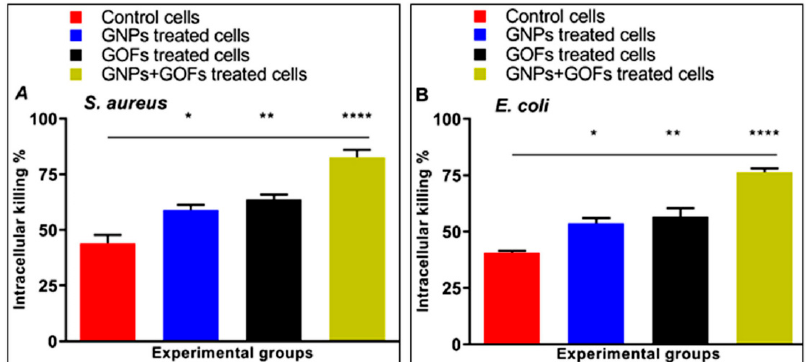
Figure 3. GNPs and GOFs increased the intracellular killing of ingested bacteria by bone-marrow-derived macrophages (BMDMs). Data are represented as mean ± SE. Statistical significance by one-way ANOVA ( p < 0.0001) followed by posthoc testing using Tukey’s multi group comparison with control cells: ( A ) * p = 0.03, ** p = 0.007, **** p < 0.0001 indicate statistically different for S. aureus , ( B ) * p = 0.02, ** p = 0.007, **** p < 0.0001 indicate statistically different for E. coli . Microorganisms 2021 , 9 , x FOR PEER REVIEW